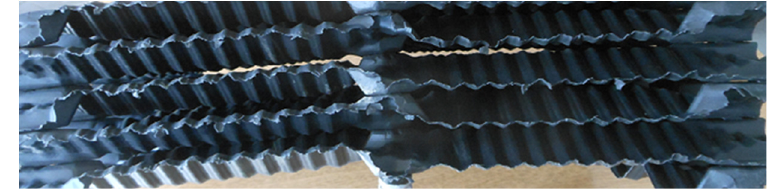
Figure 4. View of the filling packets of the cooling tower.